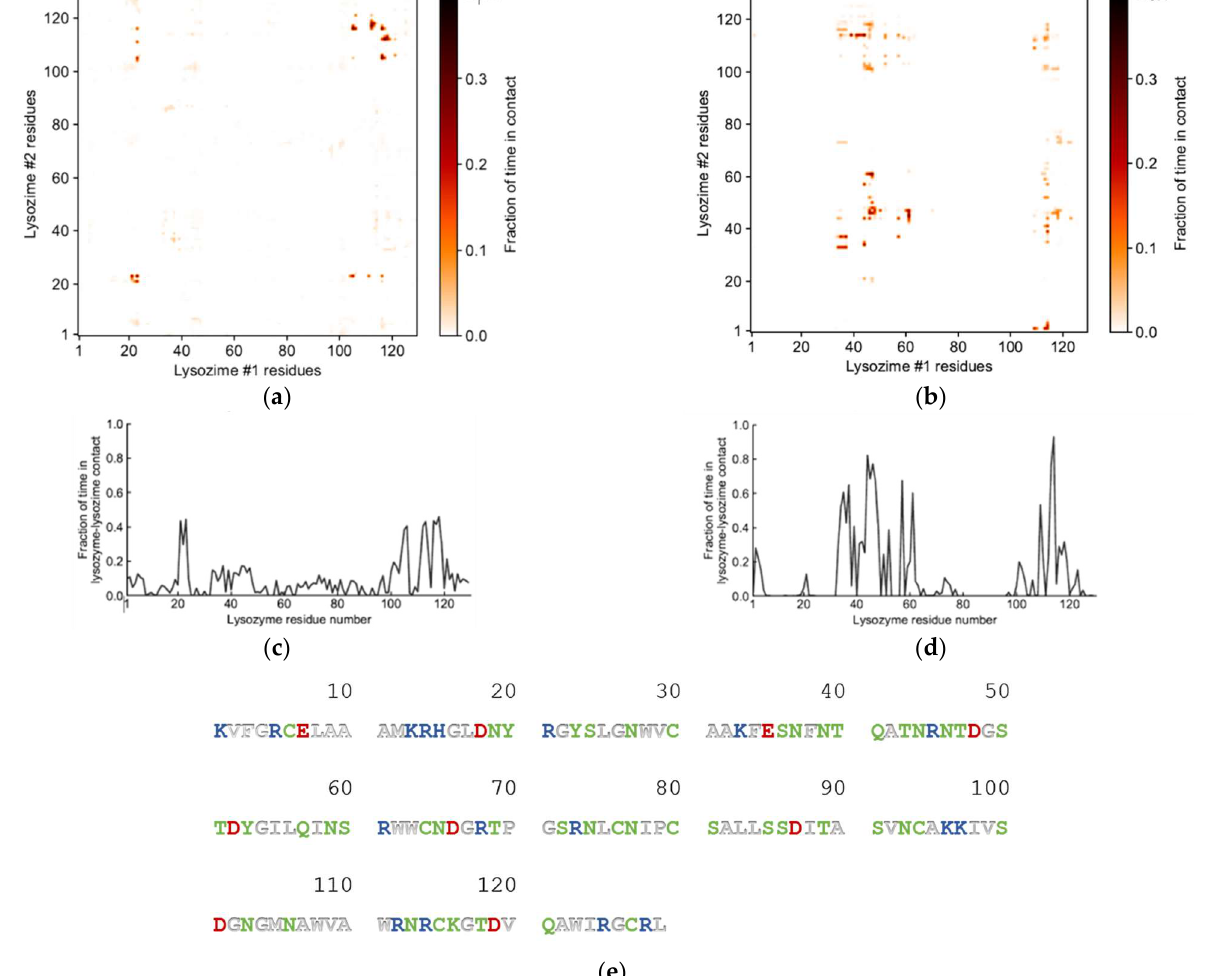
Figure 7. Lys–Lys interactions mediated by [N 1112(OH) ][C 4 F 9 SO 3 ]: heat maps of interaction between residues in the absence ( a ) and presence ( b ) of FIL, and corresponding duration of contacts ( c , d ); ( e ) sequence for Lys (PDB ID: 1DPX). Residues are represented as polar (green), apolar (white), cationic (blue), or anionic (red).